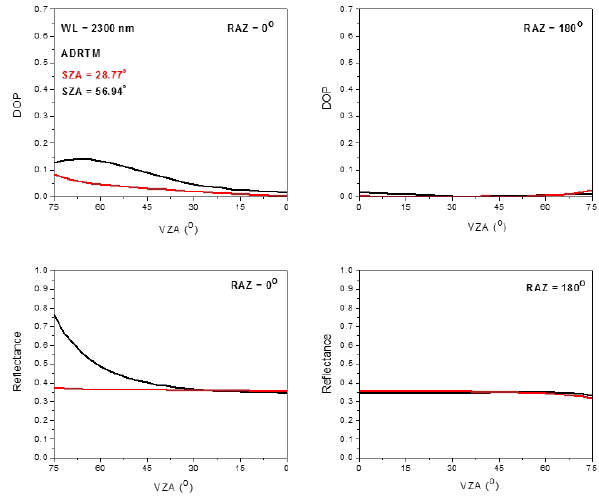
Figure 23. The modeled DOP and reflectance of desert-reflected solar light at RAZs of 0 and 180 ◦ at the wavelength of 2300nm. The SZA is 28.77 and 56.94 ◦ , respectively, in the